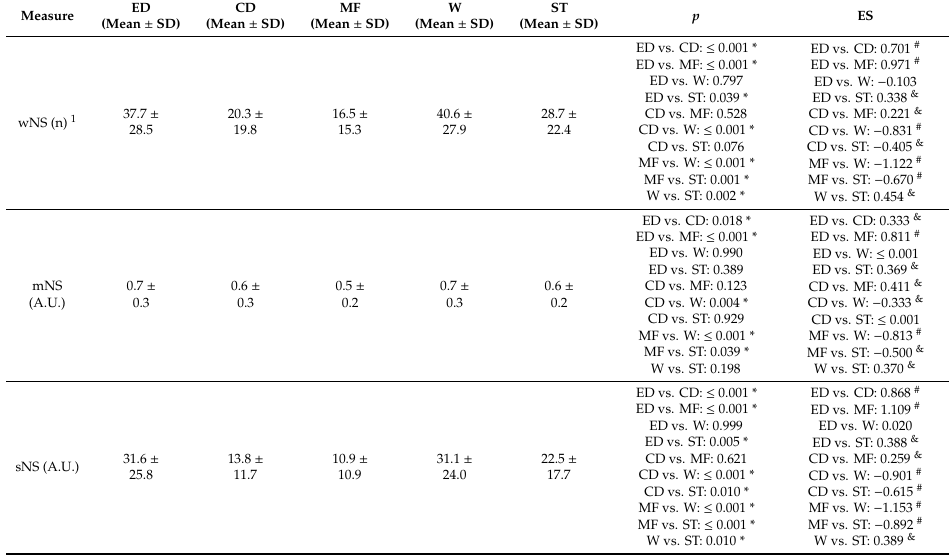
Table 5. Descriptive statistics (mean ± SD) of acute load, training monotony, and training strain for the number of sprints between playing